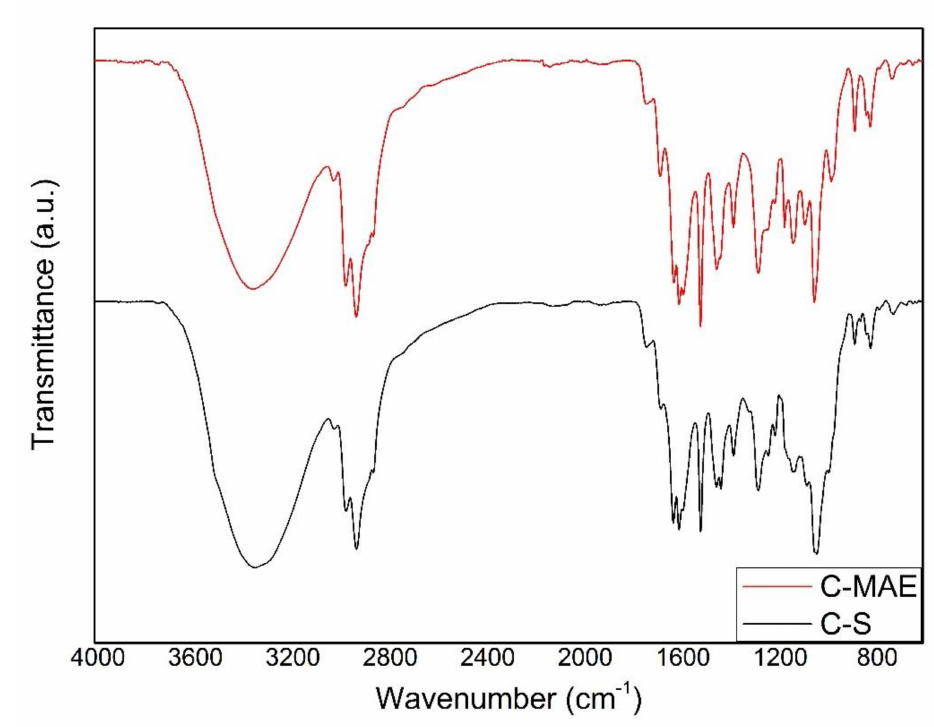
Figure 2. ATR-FTIR spectra of the Curcuma longa L. oil extracted with microwave-assisted extraction (C-MAE) and Soxhlet method